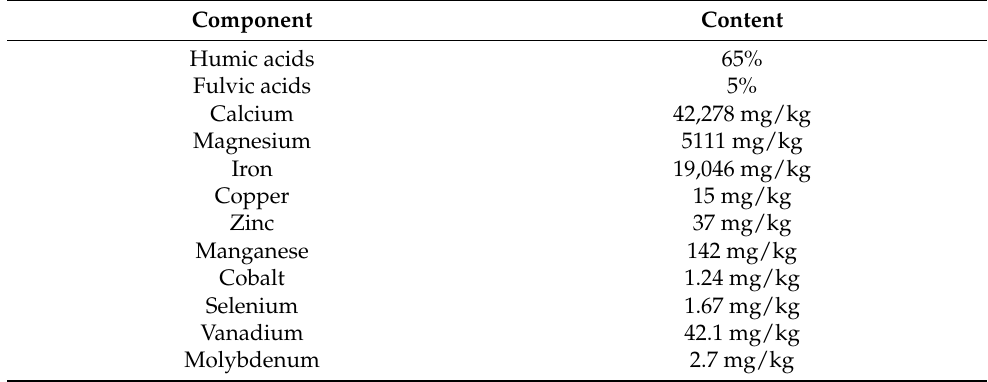
Table 1. Chemical composition of HUMAC ® Natur AFM feed additive (content in dry matter). Component